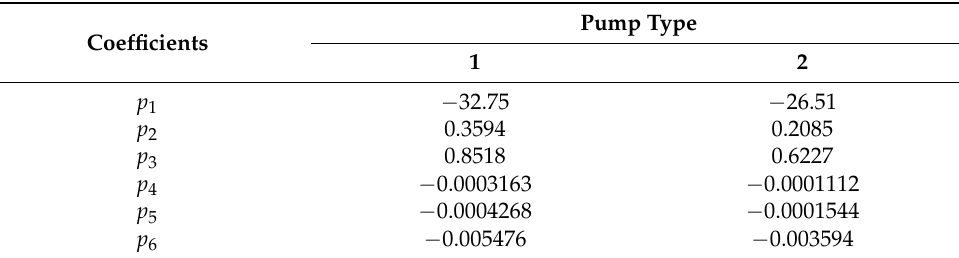
Table 2. Coefficients for the high-pressure pumps according to pump type. The coefficient of determination ( R 2 ) was 0.99 for both types of